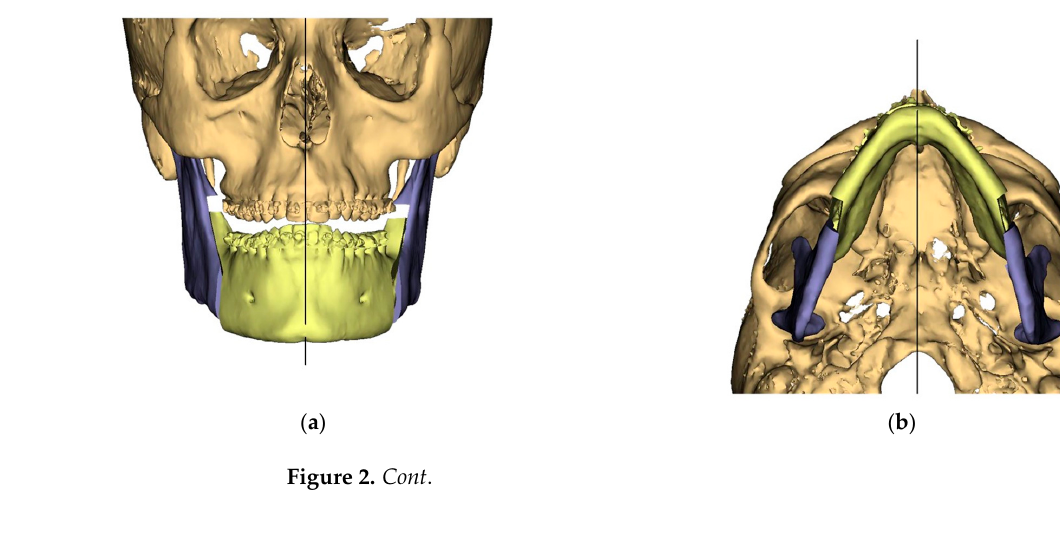
Figure 1. Surgical Plan: Preoperative situation: ( a ) Frontal view; ( b ) Occlusal view; ( c ) Right side view; ( d ) Left side view.